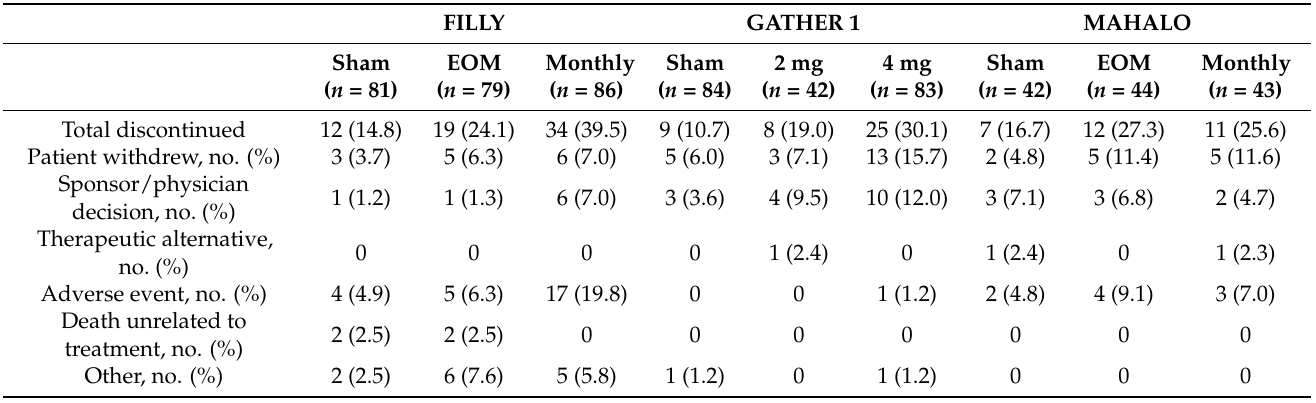
Table 3. Reasons for discontinuation in the FILLY, GATHER 1 and MAHALO studies. FILLY GATHER 1